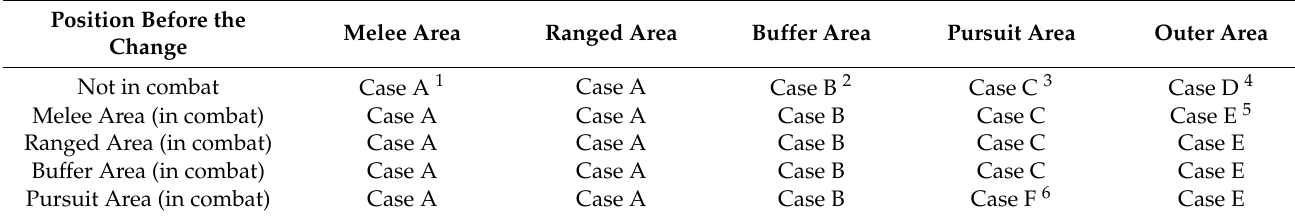
Table 2. Execution logic of RID algorithm.